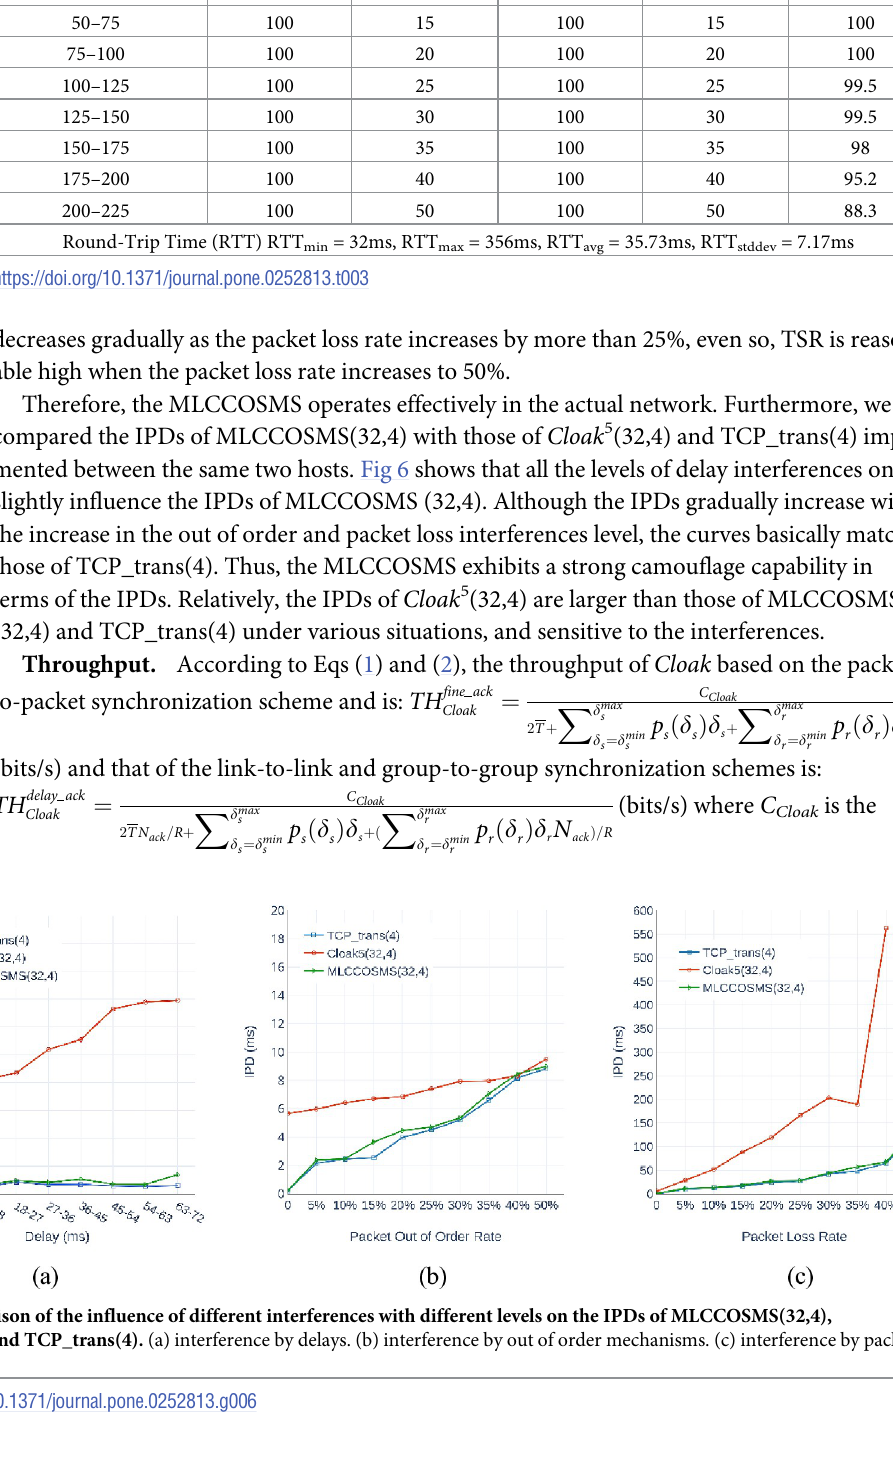
Table 3. TSR of MLCCOSMS(32,4) under three kinds of interferences with different levels.